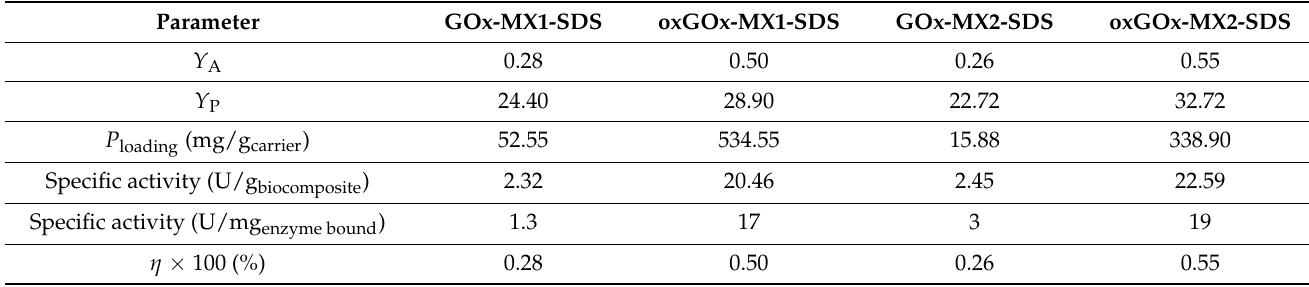
Table 3. Key immobilization performance parameters for four types of biocomposites, washed with water and additionally with 10% ( w / v ) SDS